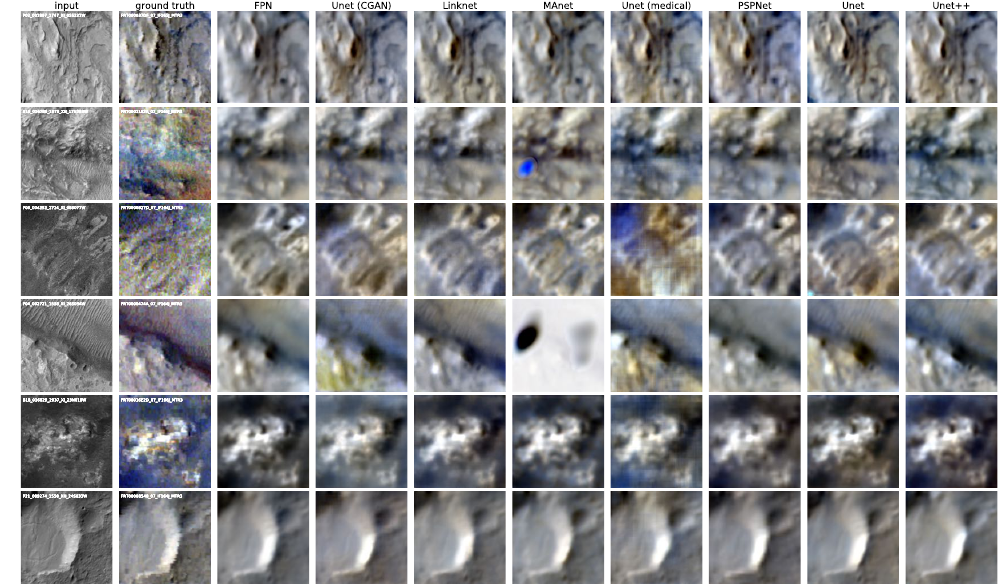
Figure 7. Appearance comparison of six EVC test patches across different model